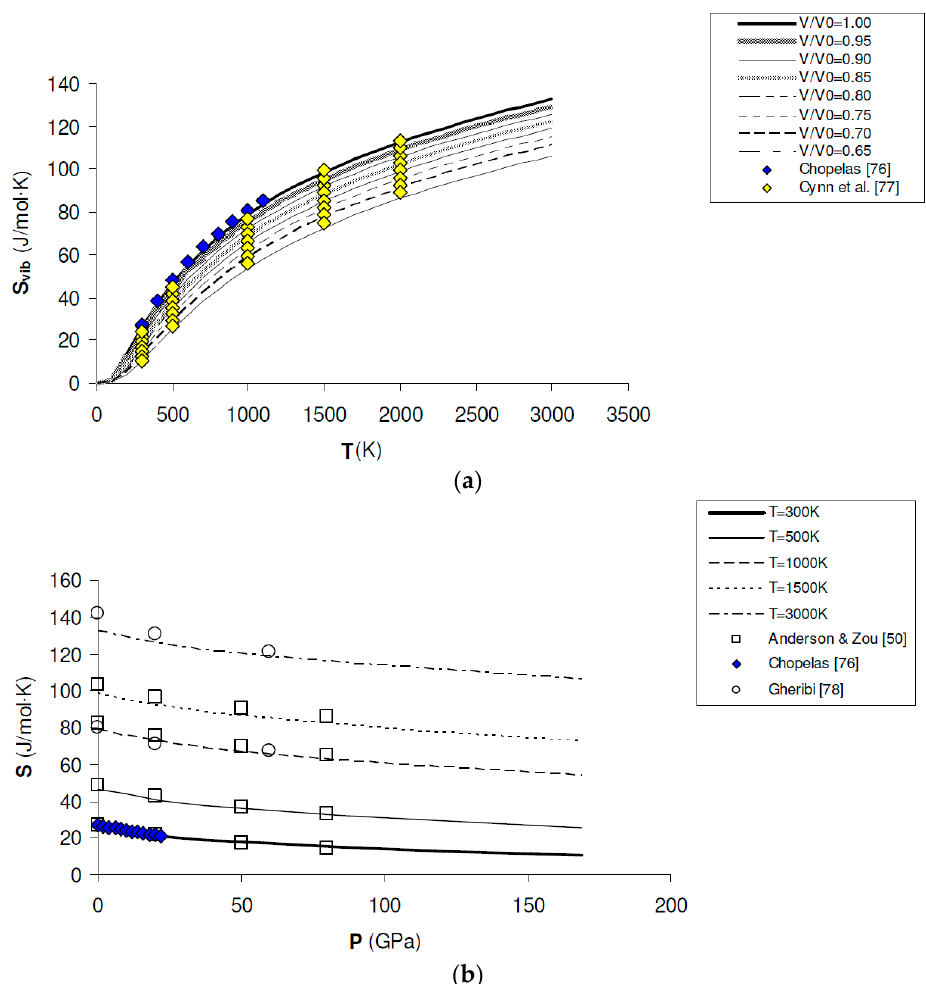
Figure 6. Ab initio B3LYP vibrational entropy (S vib ) and total entropy (S) of MgO: ( a ) calculated results along isochores (i.e., V/V 0 = 0.65, 0.70, 0.75, 0.80, 0.95, 0.90, 0.95 and 1.00), as compared to values modelled from vibrational spectroscopy experiments [76] and thermodynamic assessments [77]; ( b ) calculated results along isotherms (i.e., T = 300 K, 500 K, 1000 K, 1500 K and 3000 K), as compared to values modelled from vibrational spectroscopy experiments [76] and thermodynamic assessments [50,78].